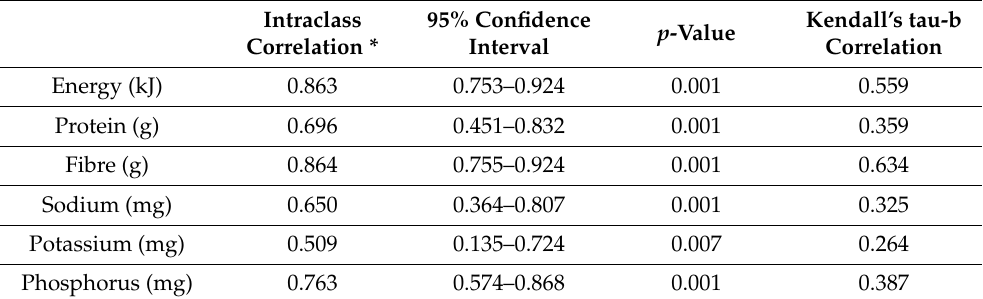
Table 4. Intraclass correlation coefficient and Kendall’s tau-b of dialysis and non-dialysis days according to 24 hr multi pass recall ( n = 46, those on PD not included n = 4).